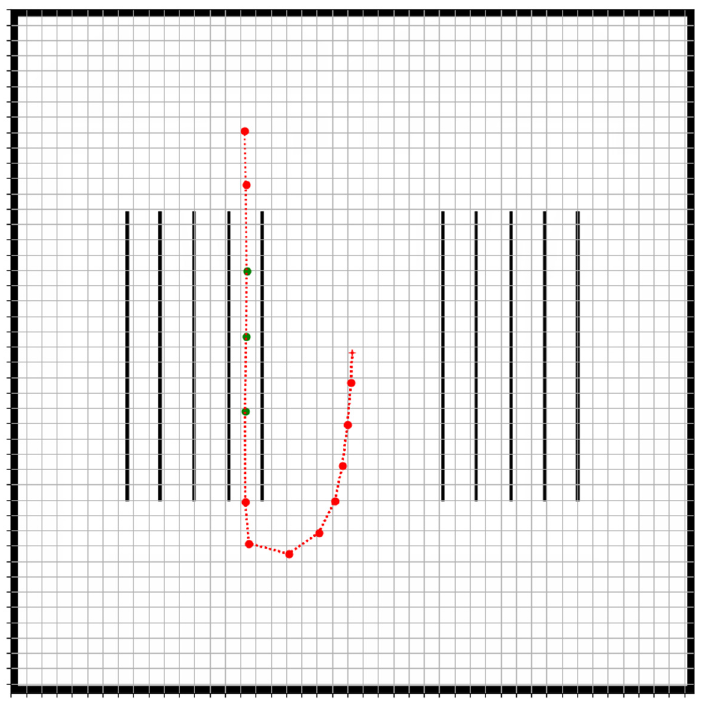
Figure 10. The second test robot path with denser waypoints. The red dots are the selected waypoints, and the red line indicates the desired robot path. The green dots are work waypoints where the robots must stop and harvest. The red cross indicates the initial position of a robot.